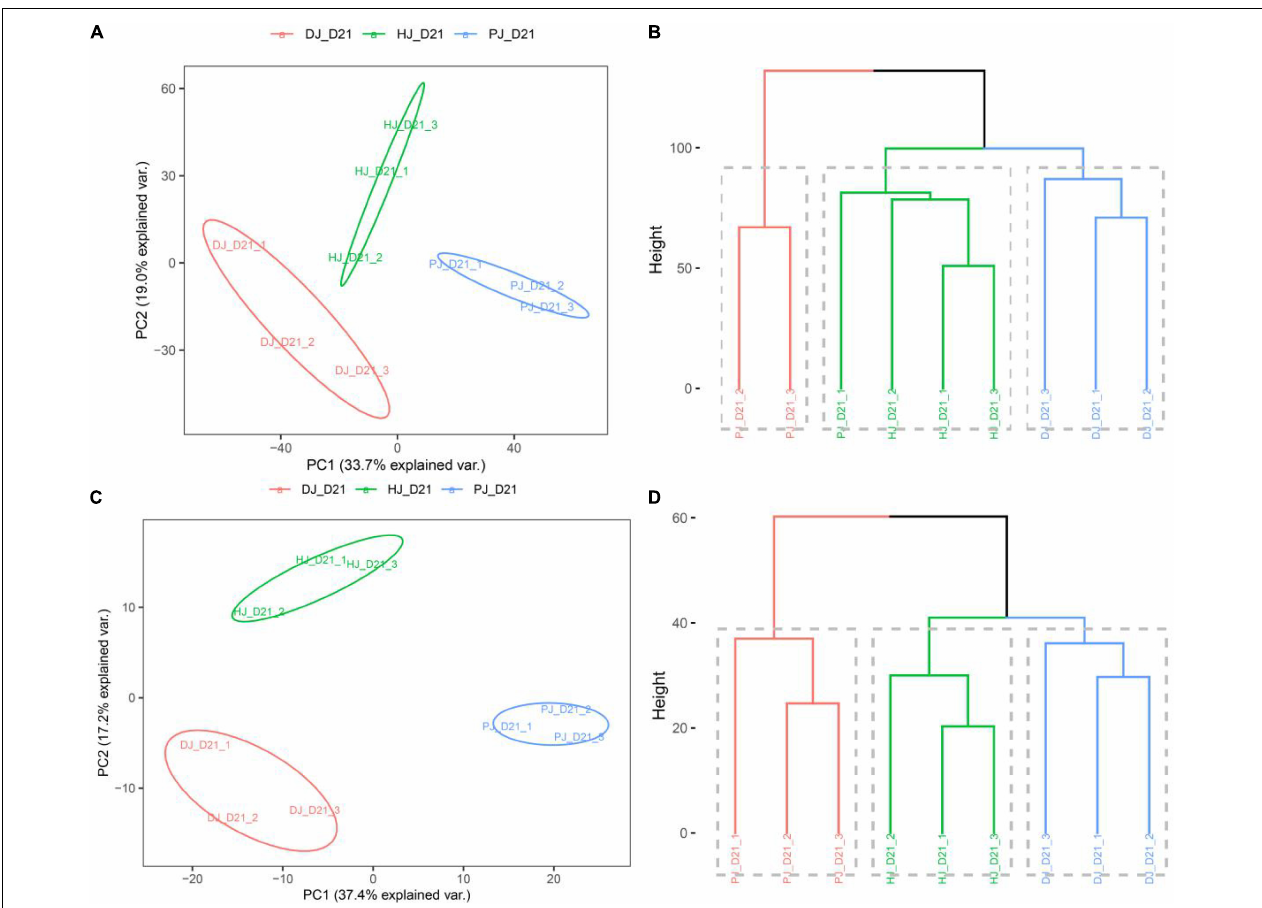
FIGURE 4 | Host and microbiota proteome landscape alterations in neonatal calves infected by E. coli K99. (A,C) PCA score plot of calf-derived and microbiome-derived proteins quantified in ≥ 50% of the samples; (B,D) group mean clustering based on Mahalanobis distances calculated with MANOVA test using the first 10 PCs of PCA on calf-derives proteins,